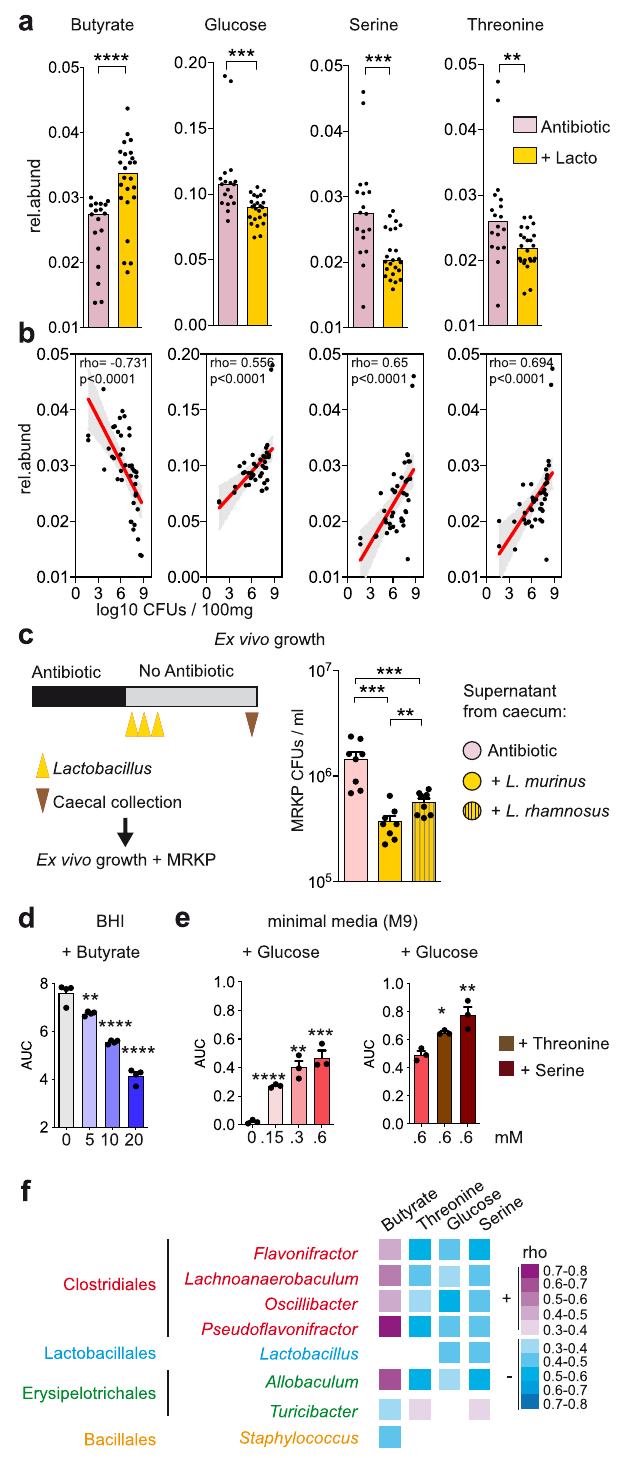
Fig. 5 | Metabolomic changes upon Lactobacillus administration generate a hostile environment for multidrug-resistant K. pneumoniae (MRKP)